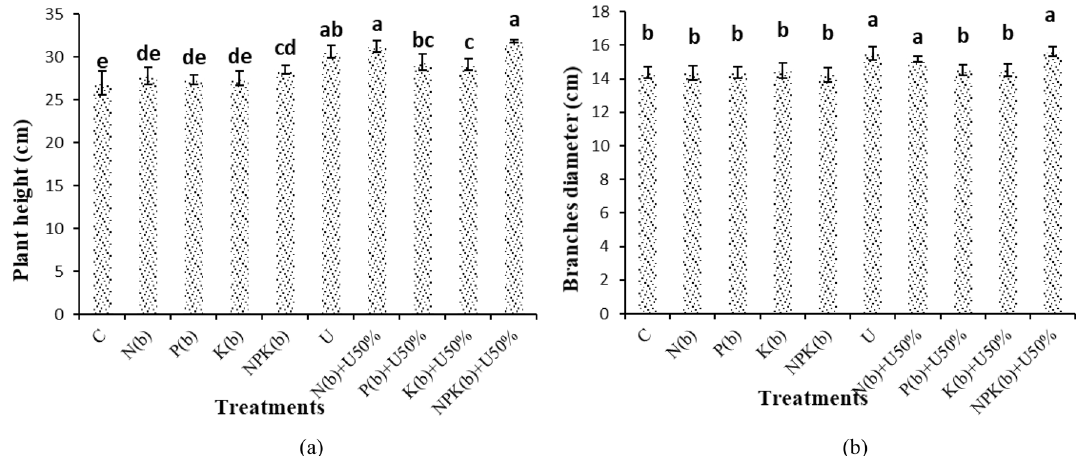
Figure 1. Means comparison for plant height and branch diameter of Nigella sativa L. as influenced by biofertilizers and urea. Dissimilar letters show significant differences at the p ≤ 0.01 level. Control (C), U Chemical urea, Nb (biological N), Pb (biological P), Kb (biological K, NPKb (mixed biological NPK), Nb + U50%, Pb + U50%, Kb + U50%, and NPKb + U50%.